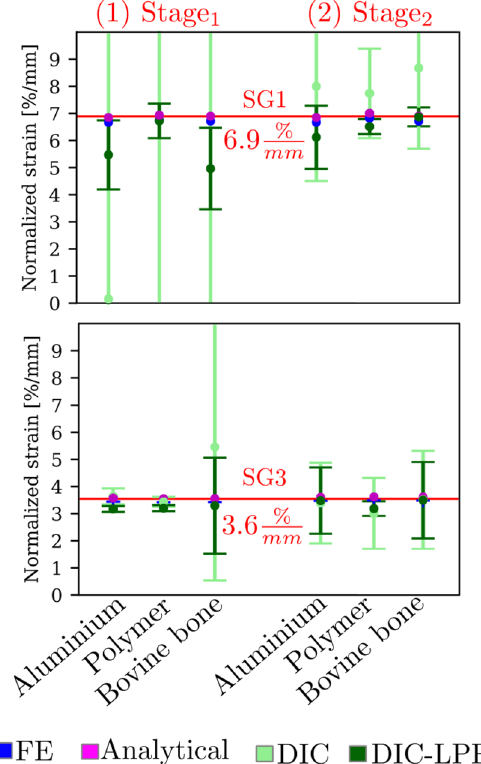
Figure 9. The normalized strain gradients at SG1 (6.9% per mm) and SG3 (3.6% per mm) is plotted for two deformation stages for aluminium, polymer, and bovine bone. The normalized strain gradient was calculated according to Eq. (2).